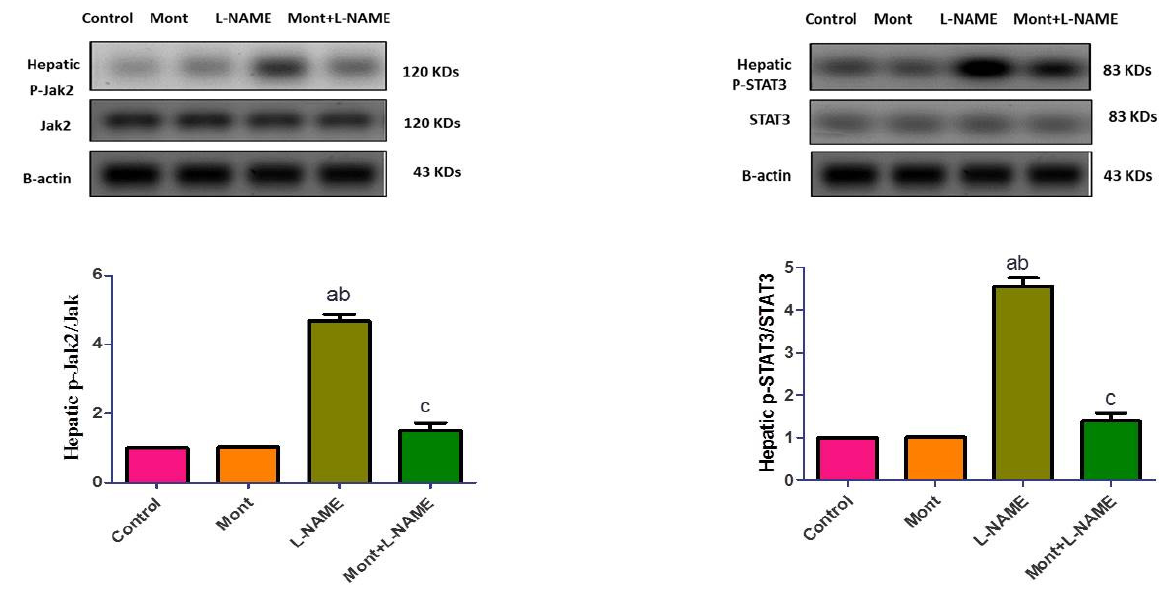
Figure 4. Effect of montelukast on hepatic p-Jak2 and p-STAT3 in a pre-eclampsia model in rats. The